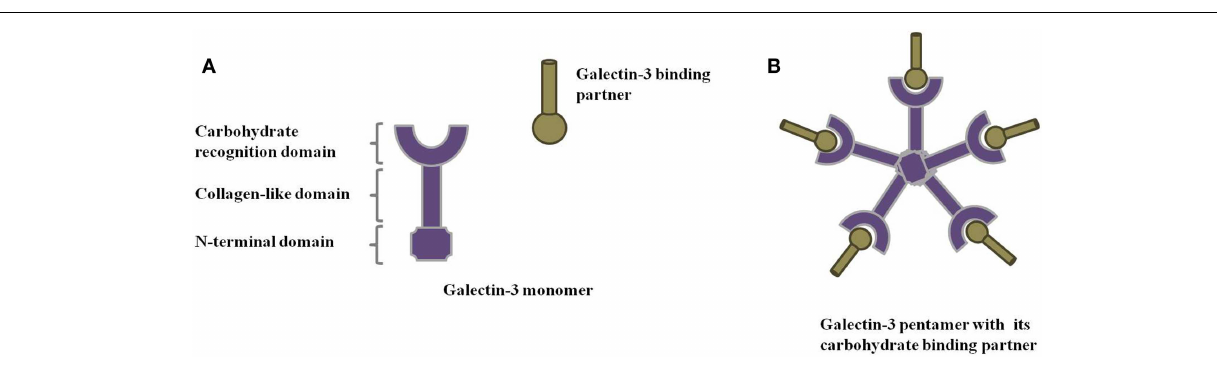
of tumor progression, suggesting an influence of this molecule in disease outcome